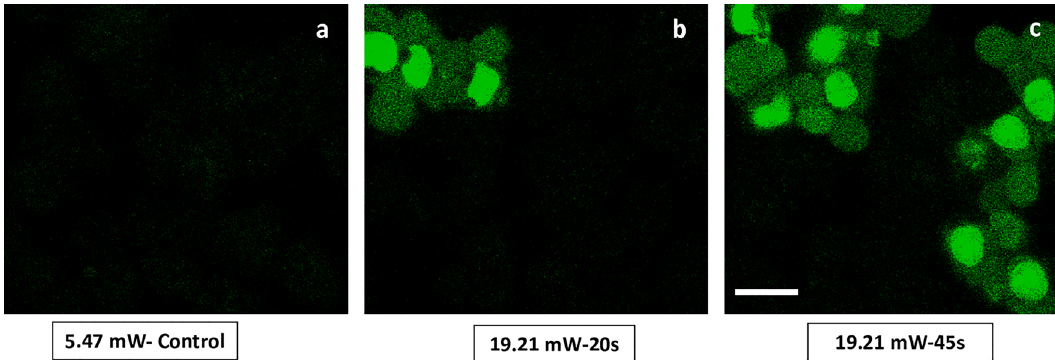
Figure 7. Induction of apoptosis with higher 2p-laser average power excitation in HeLa cells. Representative images show the signal of caspase 3/7 green detection reagent (CellEvents) imaged under identical conditions with confocal 488 nm at 2% (Em 493–579 nm, PMT 750v) after FLIM acquisition with 740 nm at ( a ) 5.47 mW– Control and after increased laser average power at ( b ) 12.88 mW and ( c ) 19.21 mW. No caspase 3/7 activation signal was detected after FLIM with ( a ) 5.47 mW–Control or with 12.88 mW (data not shown). However, after excitation with higher average power ( b ) 19.21 mW-20 s, caspase 3/7 activation signal and some apoptotic cells were observed which further increased with increase in the acquisition time ( c ) 19.21 mW-45 s. Scale bar 20